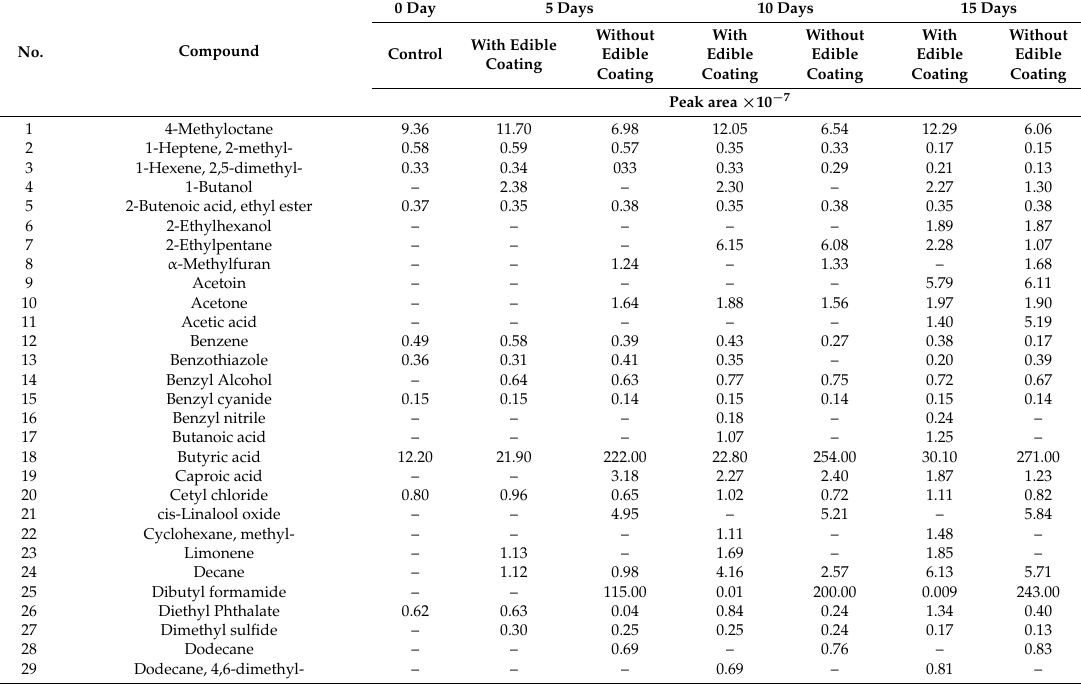
Table 1. Volatile compounds generated during papaya ripening with and without edible coating.